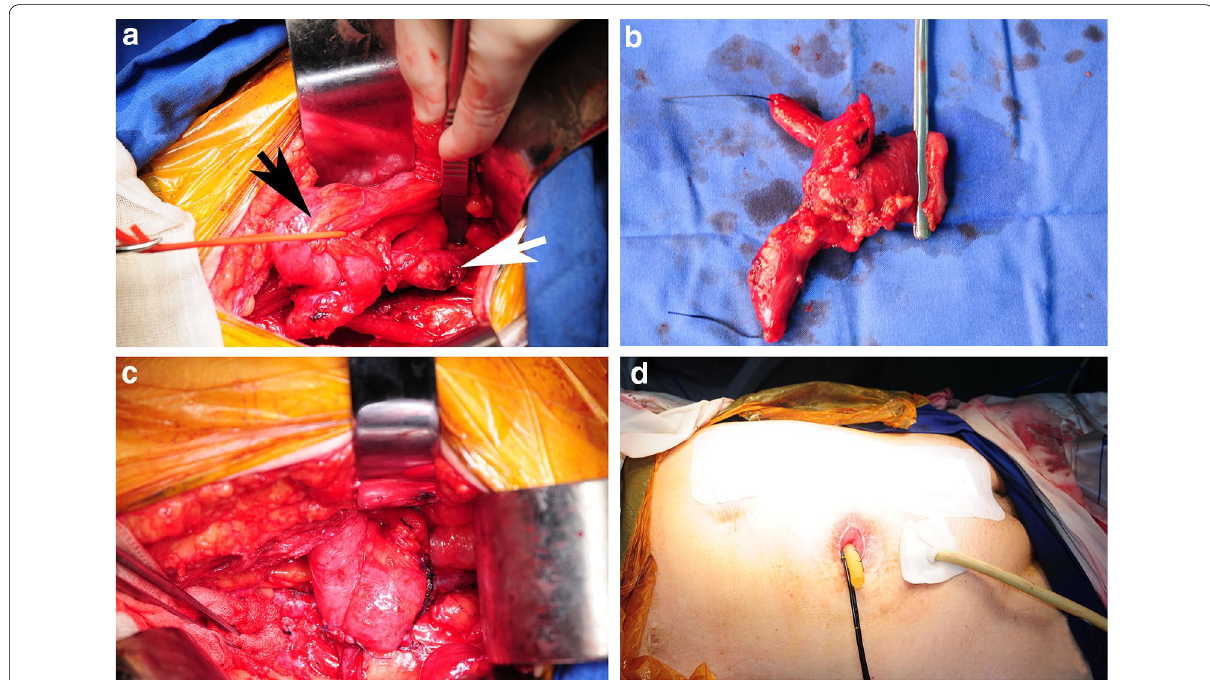
Fig. 1 Segmental ureteroileal conduit resection procedures. a . The ileal conduit ( black arrow ) and the affected ureter ( white arrow ) were exposed. b . The ureters and ileal conduit were segmentally removed. c . The transected ureter was reanastomosesed to the residual ileal conduit. d . Drainage catheters were placed in the lower abdomen and